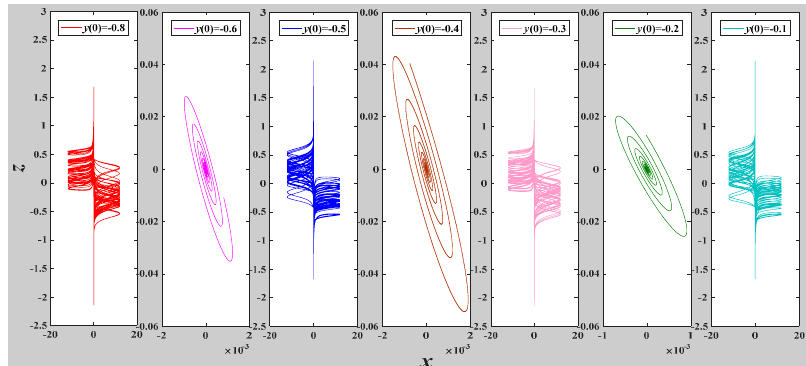
Figure 13. The state-switching between point attractors and chaotic attractors with the varying component y (0).